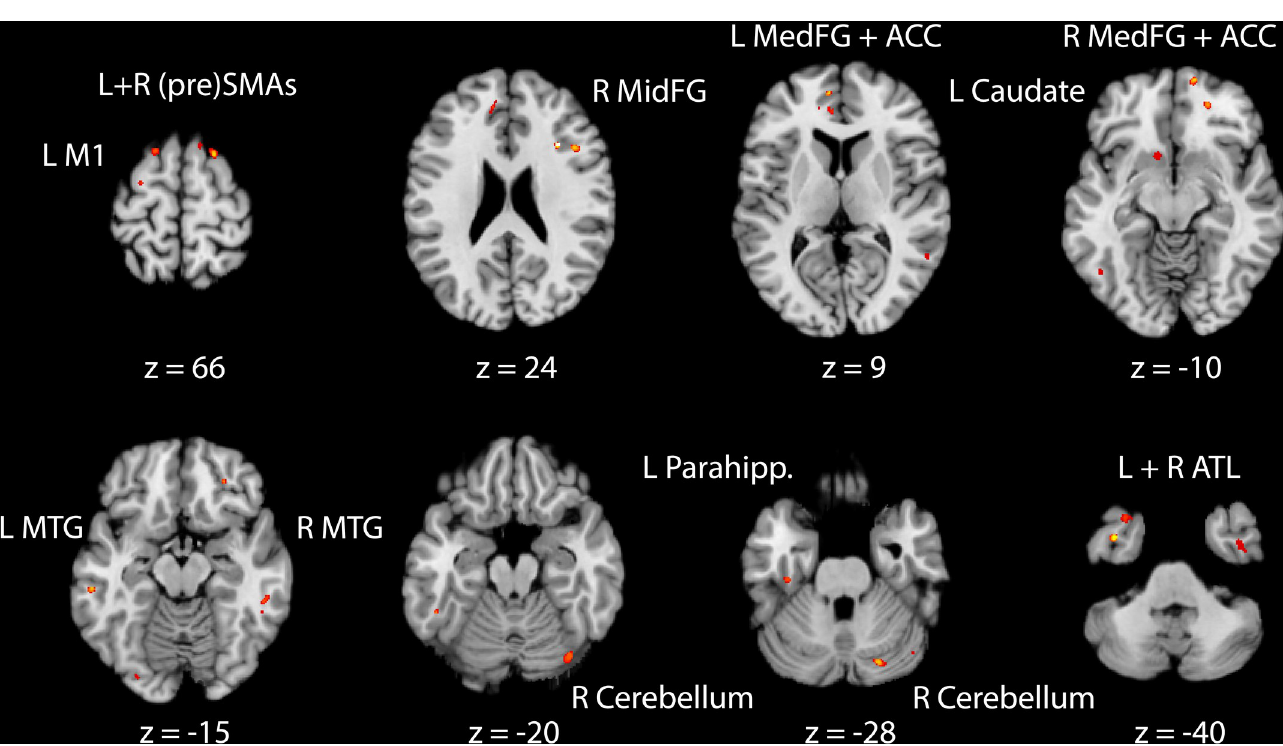
Fig 4. MVPA analysis of learning-induced GM changes (relative to the pre-learning baseline). GM voxels, which were significantly predictive (86 + − 1.5% mean accuracy) of the 2 learning groups (M1 and SPL) already on day 1, were found in bilateral MTG, bilateral ATL, anterior cingulate, medial PFC, bilateral (pre) SMAs, left M1, left caudate, left parahippocampus, and right cerebellum. The data underlying this figure are provided on the Open Science Framework (https://osf. io/k9ngw). ACC, anterior cingulate cortex; ATL, anterior-temporal lobe; FG, frontal gyrus; GM AU : PleasedefineACCCandSMAsinFig 4 abbreviationlistiftheseindeedareabbreviations : , grey matter; MTG, middle temporal gyrus; MVPA, multivoxel pattern analysis; PFC, prefrontal cortex; SMAs, supplementary motor